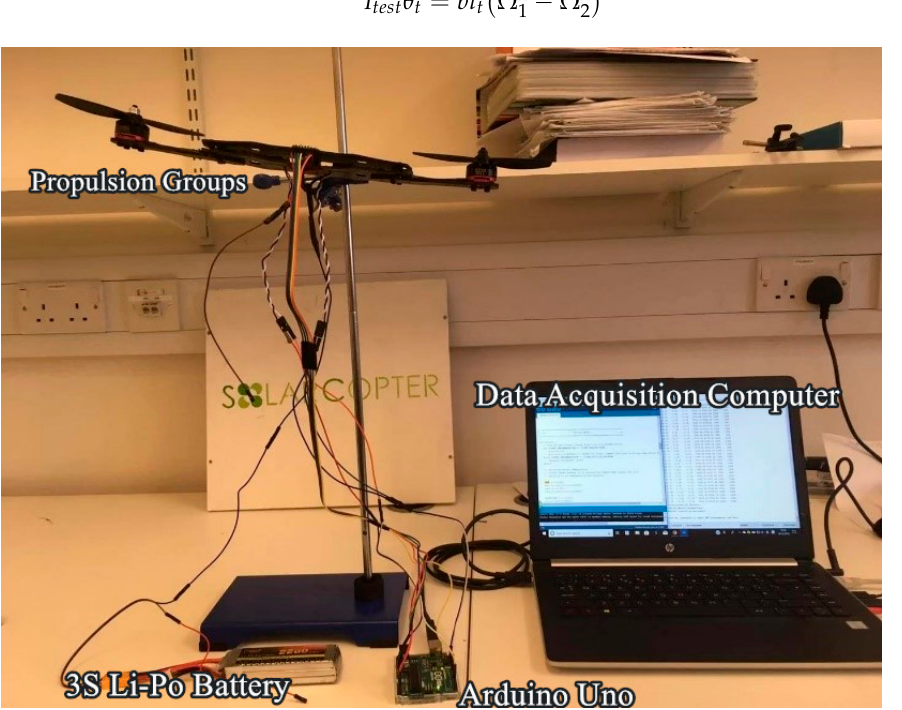
Figure 6 . Two motors test bench . Figure 6. Two motors test